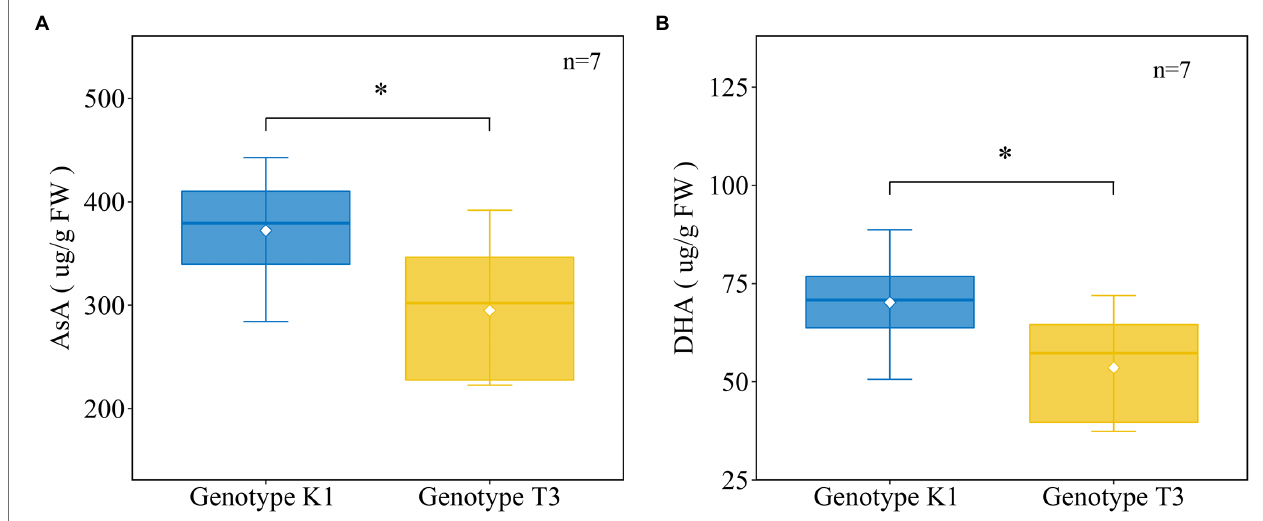
FIGURE 8 | The amount of ascorbic acid (AsA) (A) , dehydroascorbate (DHA) (B) in strawberry leaves of Kreuzkogel 1 (K1) and Tenno 3 (T3) without B. cinerea inoculation. The asterisk ‘ * ’ indicates significant differences among the two genotypes determined by a t -test at p < 0.05.